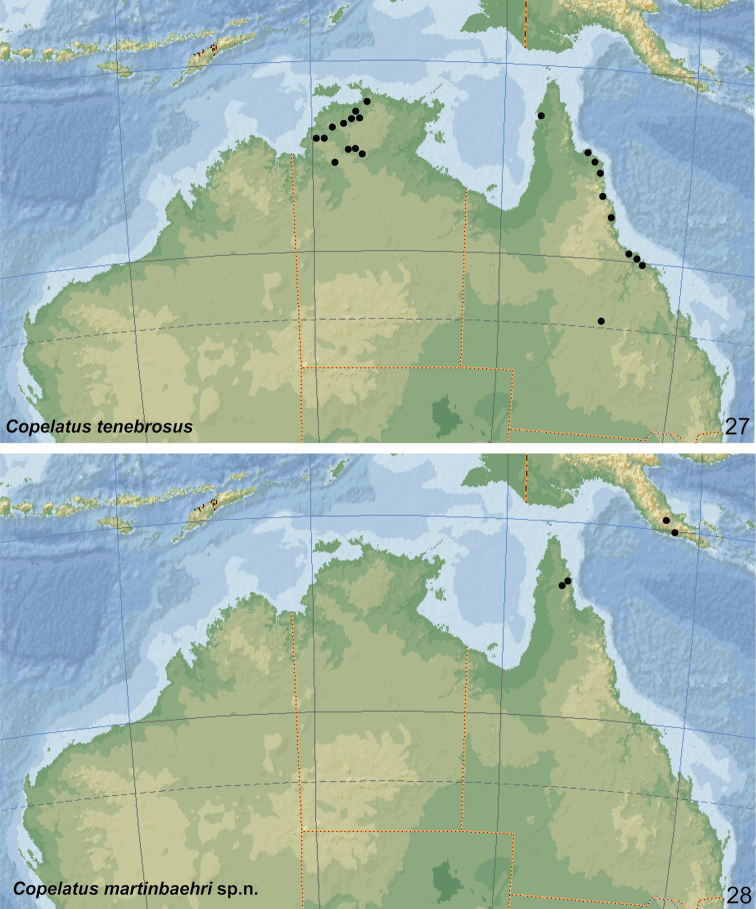
Distribution of 27Copelatus
tenebrosus28C.
martinbaehri sp. nov.